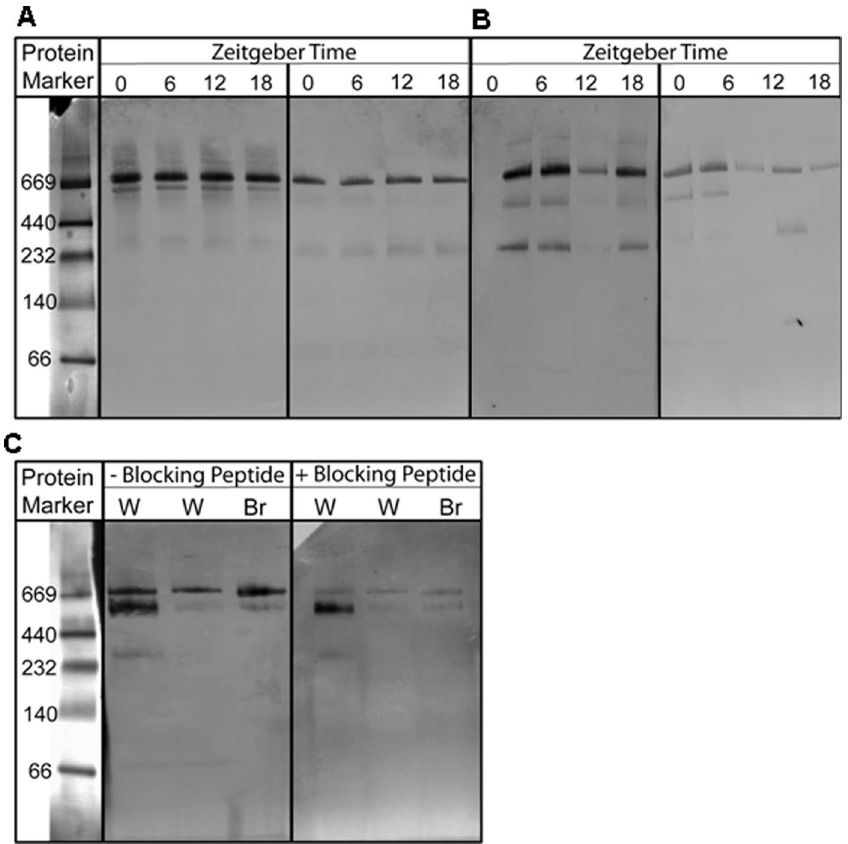
Figure 2. Multiple isoforms of white-throated sparrow plasma adiponectin. Western blot analysis of plasma ADP under native conditions. Representative western blots from two white-throated sparrows A, female sparrow in non-migrating condition in the left panel; same bird under migrating conditions in the right panel where plasma samples were collected at four times of day (ZT 0, 6, 12, 18). B, Male non-migrating condition in the left panel; same bird under migrating conditions in the right panel where plasma samples were collected at four times of day (ZT 0, 6, 12, 18). For all birds, lights came on at ZT0 and went out at ZT 12. C, white-throated sparrow (W) and broiler chicken (Br) plasma separated under native conditions. Primary anti-chicken antibody was either not preadsorbed ( 2 blocking peptide), or preadsorbed with adiponectin peptide ( + blocking peptide). A high molecular weight protein marker was included to determine molecular weight (kDa) of adiponectin isoforms.